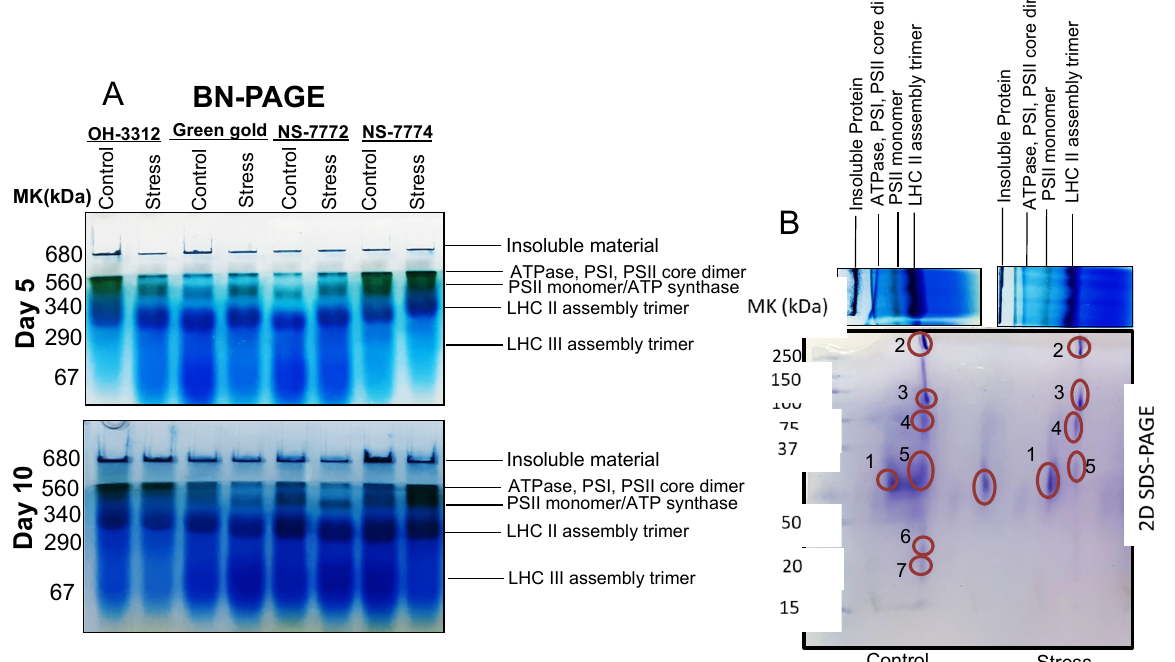
Figure 12. ( A ) First dimension BN-PAGE, as affected by drought stress at 5 and 10 days of interval in okra genotypes NS7774, NS7772, Green Gold, and OH3312, along with respective controls. ( B ) 2D-SDS-PAGE of thylakoid protein complex isolated from NS7774 exposed to drought stress for day 10 along with the control samples. For first dimension BN-PAGE, fresh thylakoid membranes of all okra genotypes were solubilized in 1% BDM at chlorophyll concentration of 1 µ g · µ L − 1 , and the protein sample was separated by 7–12.5% gradient BN-PAGE. For second dimension, gels slices were horizontally laid on top of 12.5% SDS-PAGE and stained with a commercial Coomassie Brilliant Blue R-250 (Bio-Rad, Hercules, CA, USA). Protein identification was based on previous reports and confirmed by MALDI-TOF/TOF-MS, shown in Table 1. Table 1. Proteins identified in 2D-BN-SDS-PAGE map of okra thylakoids.